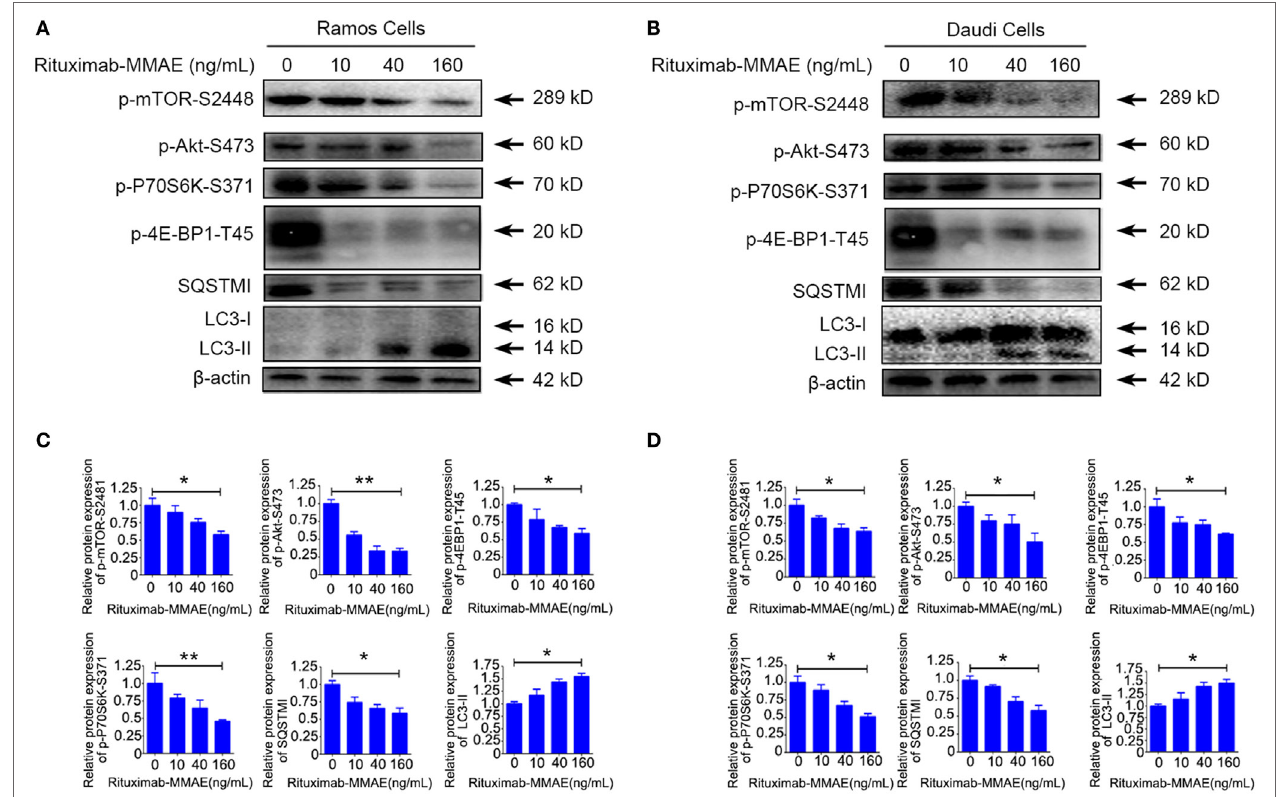
FigUre 4 | Inactivation of Akt/mTOR signal pathway induced by Rituximab-monomethyl auristatin E (MMAE) treatment. (a,B) Ramos cells and Daudi cells were exposed to various concentration of Rituximab-MMAE for 24 h, and whole-cell lysates were analyzed by western blot to examine the expression of SQSTM1, LC3, p-Akt, p-mTOR, p-P70S6K, and p-4E-BP1. (c,D) Densitometric values were quantified by Image J software and normalized to control. The values of control were set to 1.0. The data were presented as means ± SD of three independent experiments (Student’s t -test, * P < 0.05 and ** P <